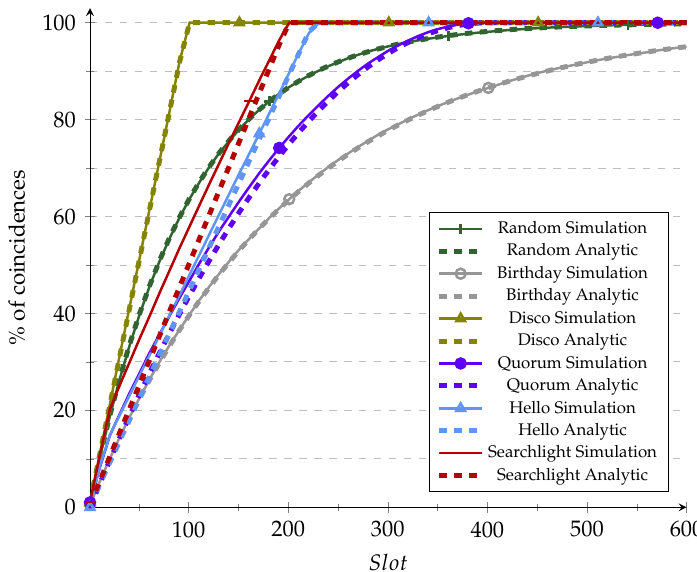
Figure 9. Validation of the simulation vs. analytic models for 10% duty cycle.